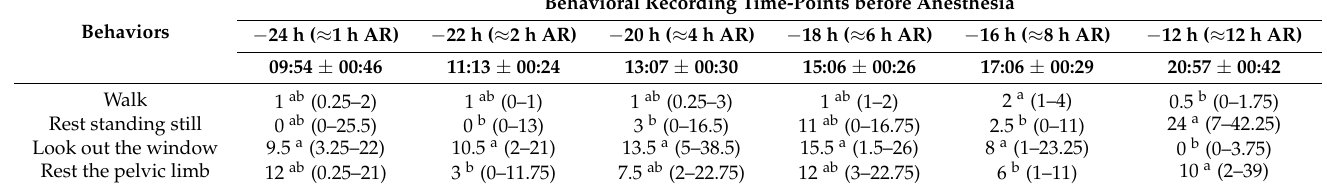
Table 3. Median and interquartile range (Q1; Q3) of the behavior duration of 24 horses recorded 24 h before anesthesia for all groups together. Different lowercase letters indicate significant difference over time (a > b > c). AR = after the end of the anesthetic recovery (to investigate the effect of the recording time, the frequency, and duration of behaviors were analyzed on the day before anesthesia combining all groups, because all horses were under the same conditions and had not undergone any procedure yet).